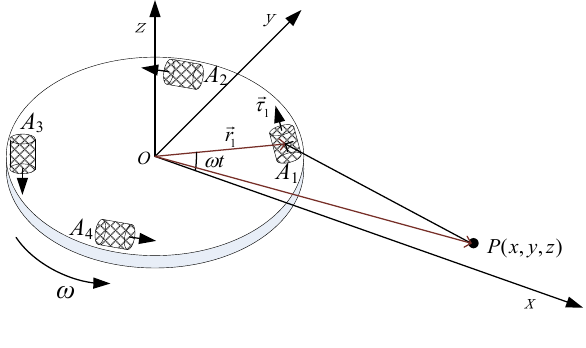
Figure 2. Schematic diagram for the particle act on the